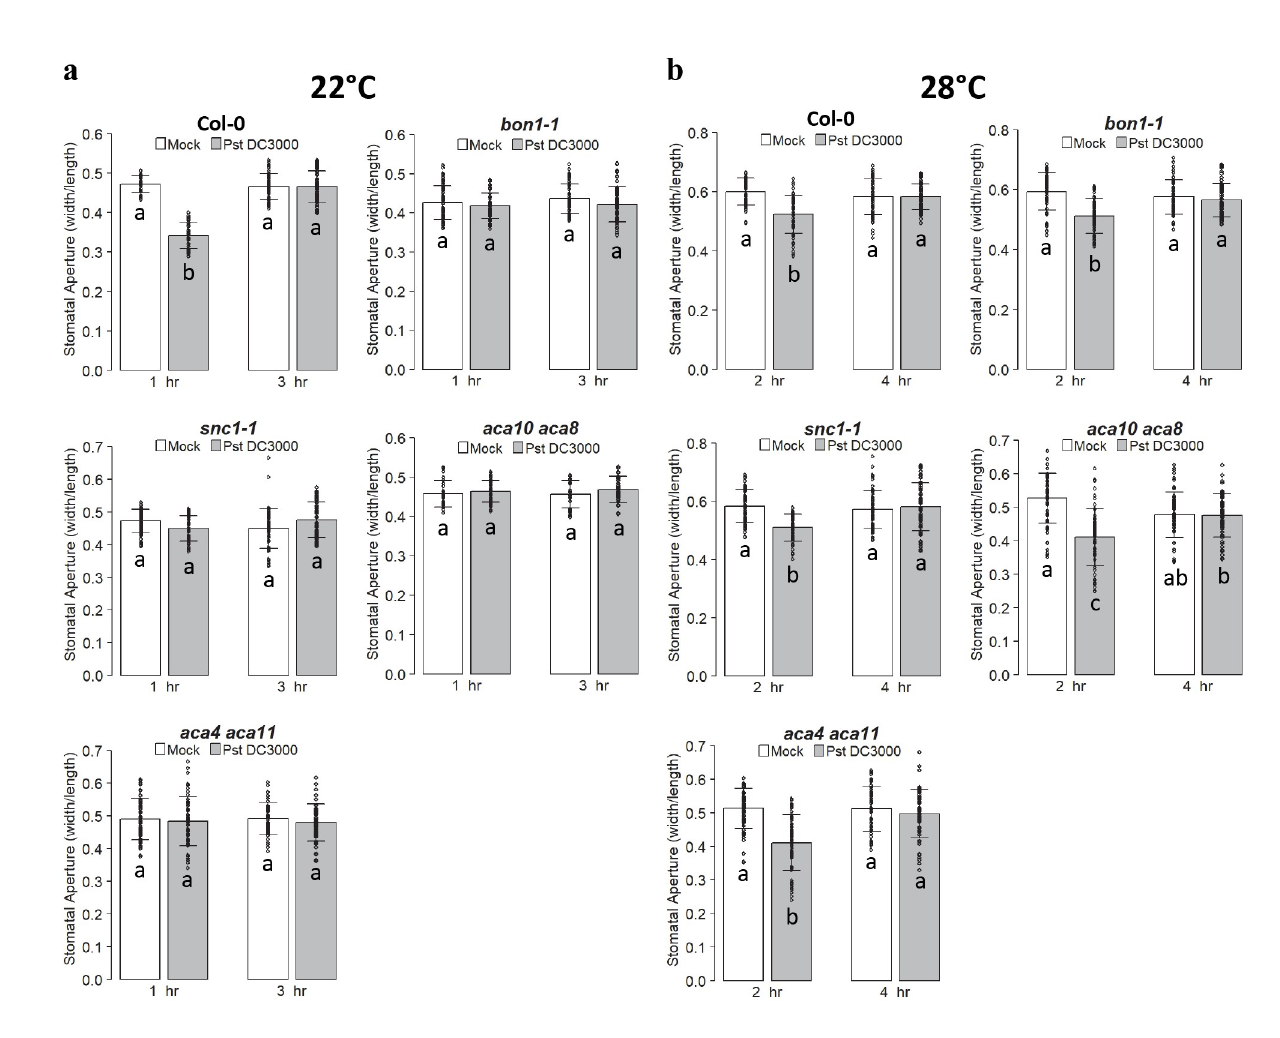
Fig 2. Mutants bon1-1 , snc1-1 , aca10 aca8 and aca4 aca11 exhibit a temperature-dependent stomatal closure defect in response to Pst DC3000. Shown are stomatal apertures in response to Pst DC3000 or buffer alone (mock) in the autoimmune mutants bon1-1 , snc1-1 , aca10 aca8 and aca4 aca11 as well as the wild-type Col-0 at 22˚C ( a ) and 28˚C ( b ). Biological duplicates were averaged and statistically analyzed with one-way Anova followed by Tukey-Kramer test. Different letters indicate statistically significant difference ( p < 0.001) and error bars indicate SDs (n = 60